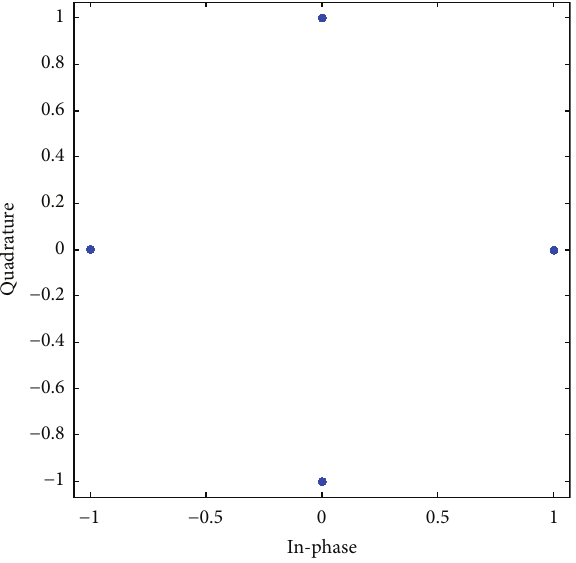
Figure 13: Recovered symbols scatter plot for 𝑀 = 4